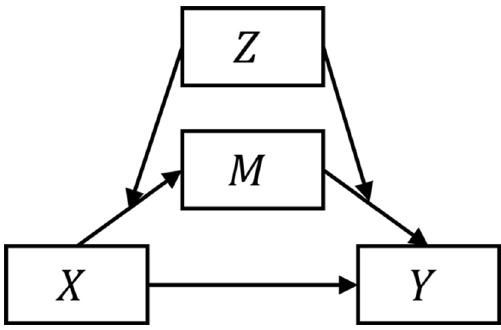
First and Second Stage Moderated